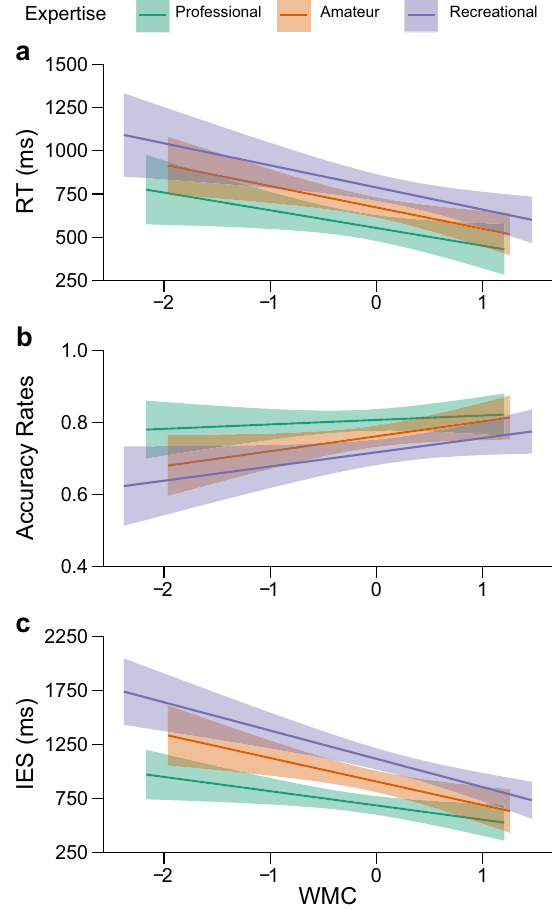
Fig. 3 The effect of WMC on the a RTs (in ms), b accuracy rates, and c IESs (in ms) in tactical decision-making under distraction at different levels of soccer